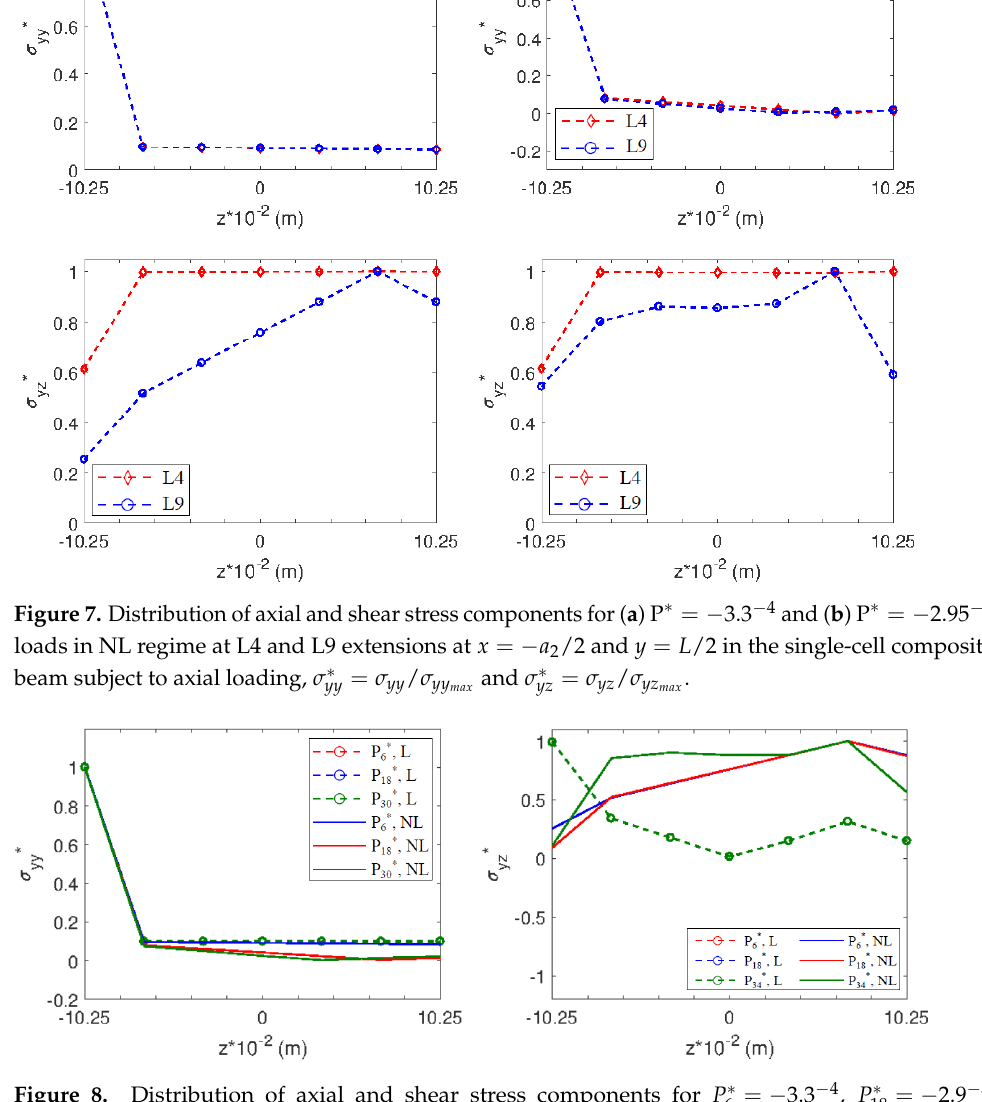
Figure 8. Distribution of axial and shear stress components for P ∗ = − 3.0 − 3 values in L9 for the single-cell composite beam subjected to axial loading; and P ∗ 30 σ ∗ yy = σ yy / σ yy and σ ∗ yz = σ yz / σ yz (at x = − a 2 /2 and y = L max max